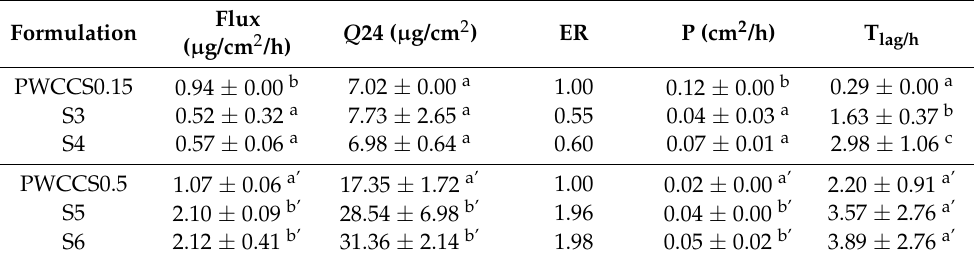
Table 2. Permeability parameters of PWCCS0.15, PWCCS0.5, and the hydrogel formulations S3, S4, S5, and S6.